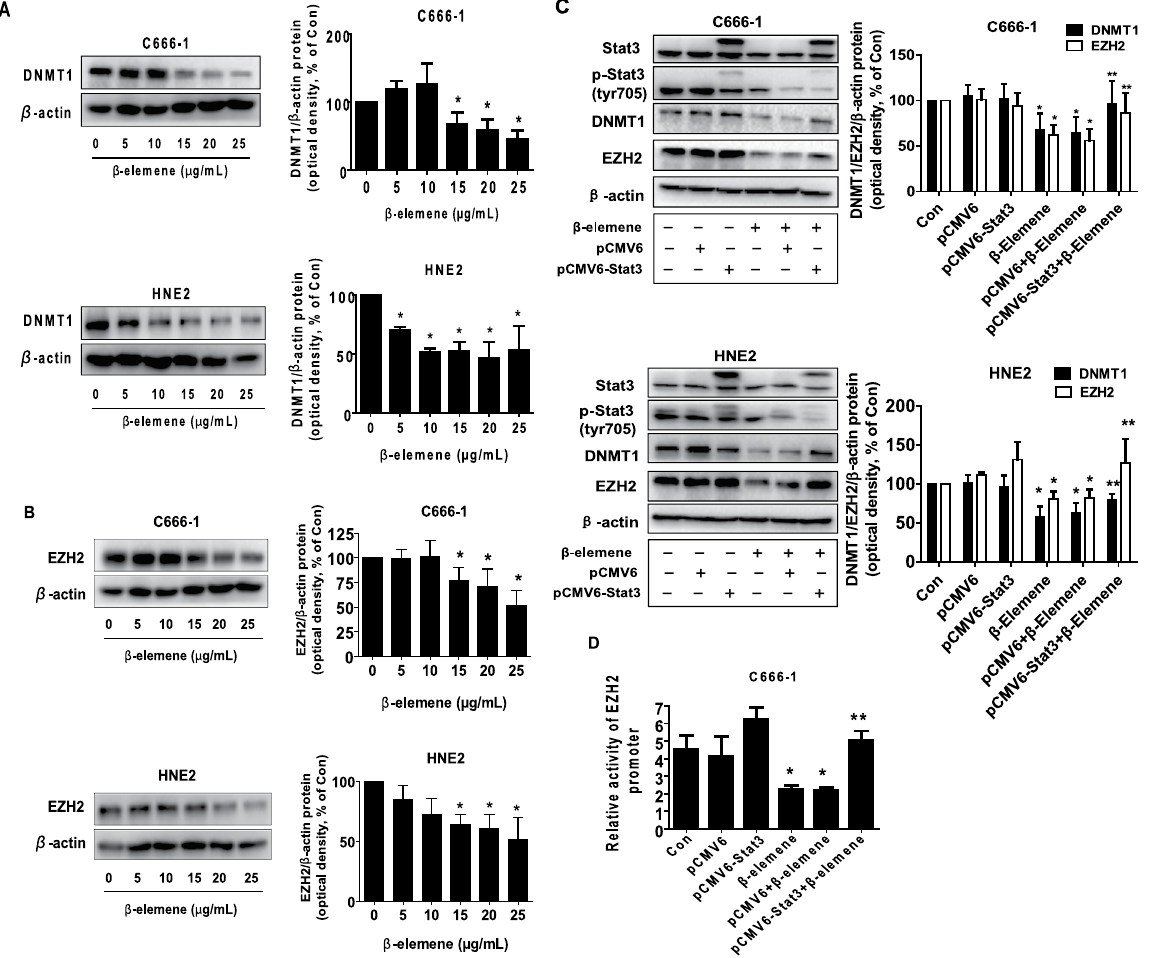
Figure 3. β -elemene inhibited the protein expression of DNMT1 and EZH2 through Stat3. ( A,B) C666-1 and HNE2 cells were exposed to increased concentrations of β -elemene for 24 h, followed by measuring DNMT1 and EZH2 proteins by Western blot. ( C ) C666-1 and HNE2 cells were transfected with control or Stat3 expression vector described in the Materials and Methods section for 24 h followed by exposure the cells